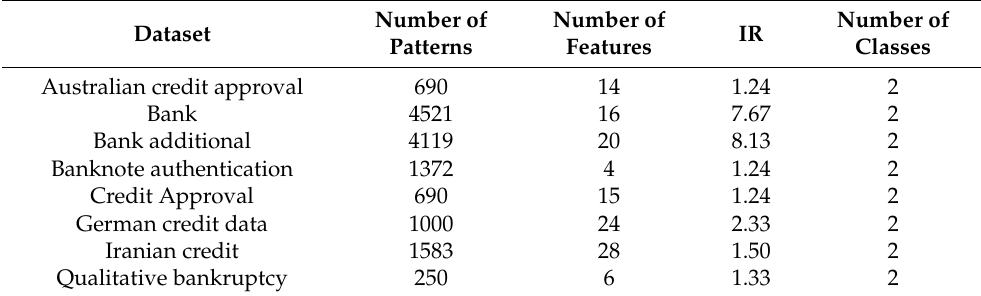
Table 1. Specifications of the datasets (in alphabetical